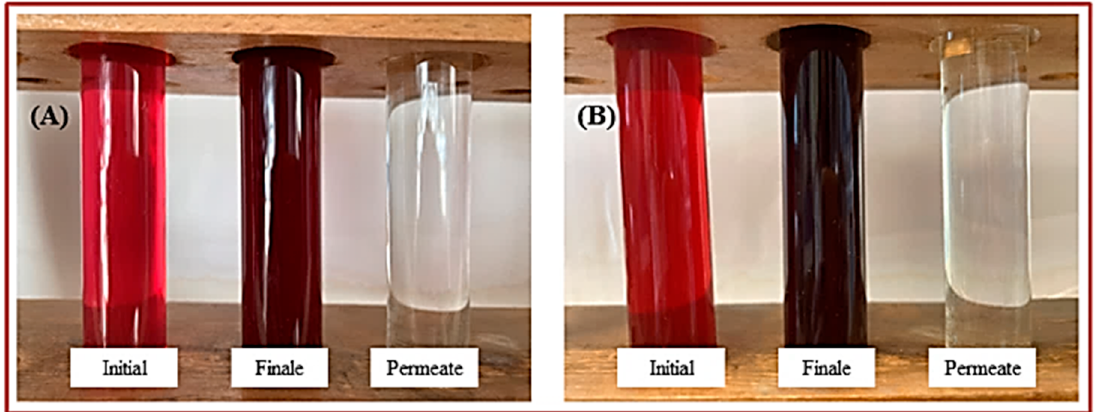
Figure 6. Crude extracts, retentates, and permeates of beetroot flesh ( A ) and peel ( B ).